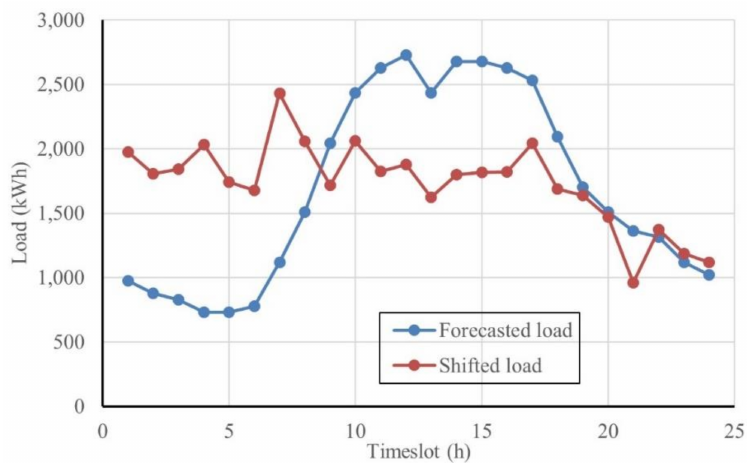
Figure 19. Hourly industrial load before and after DSM using the centralized algorithm